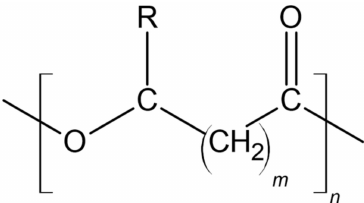
Figure 2. Polyhydroxyalkanoates (PHA) general structure, where m ranges from 1 to 3, with 1 being most common, as in polyhydroxybutyrates (PHB), n is the degree of polymerization with values from 100 to 30,000, and the variable R is the alkyl group with di ff erent chain lengths and structures in PHB. R =